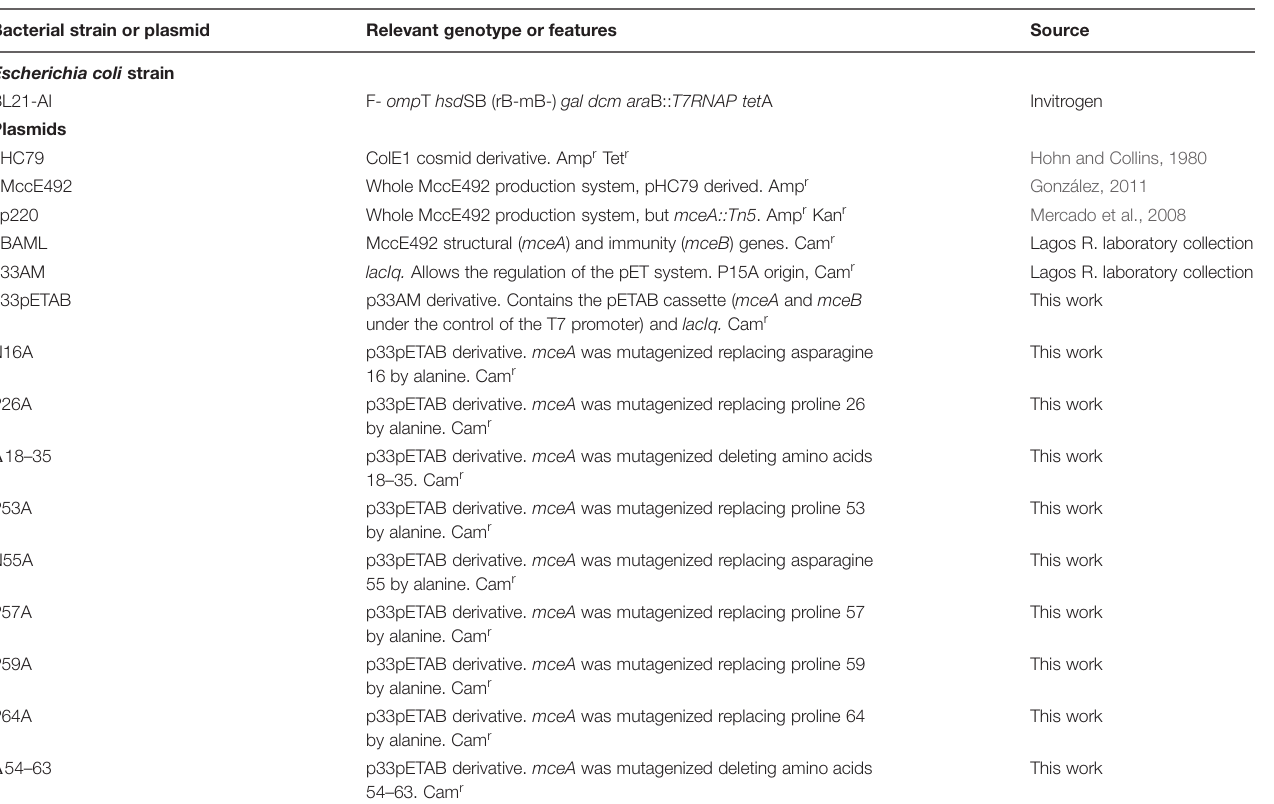
TABLE 1 | Bacterial strain and plasmids used in this